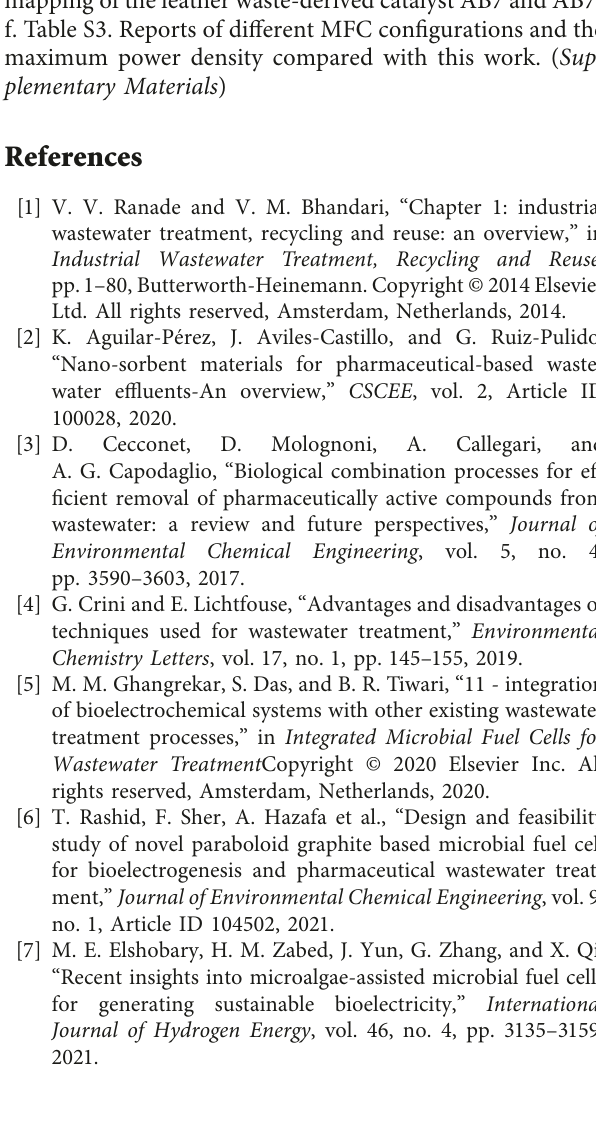
Figure S1. (a) Biofilm grow method and (b) dual-chambered H-Type MFC configuration used in this work. Table S2.